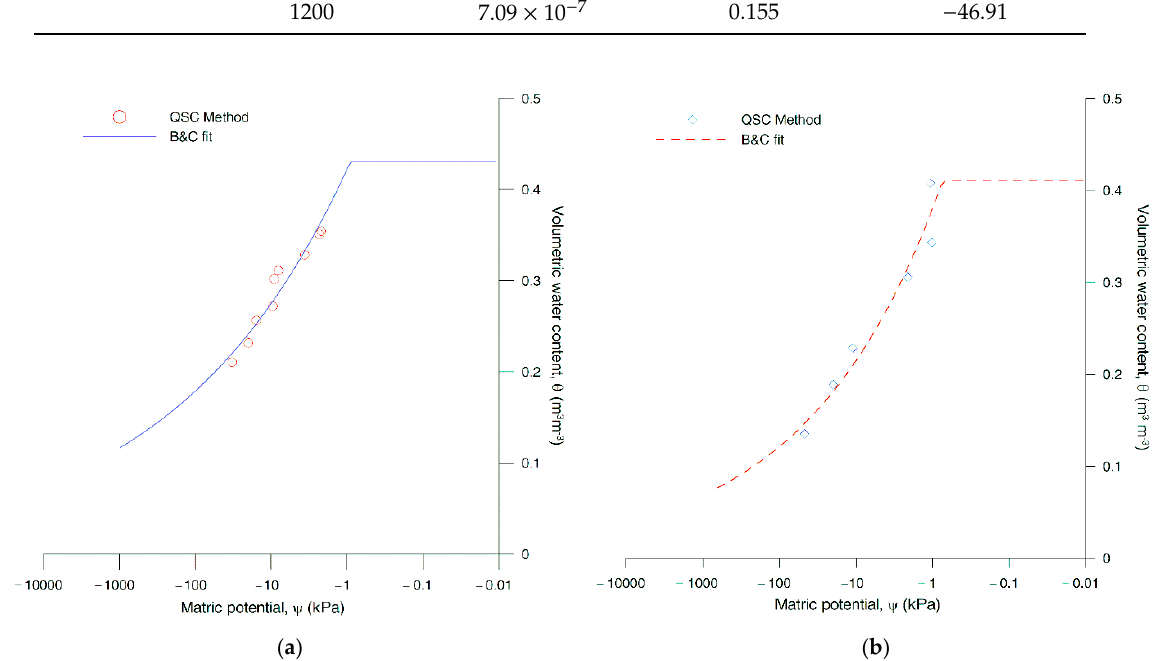
Figure 6. Fitting of the experimental water retention points with the Brooks and Corey model: ( a ) lithotype C; and ( b ) lithotype M.